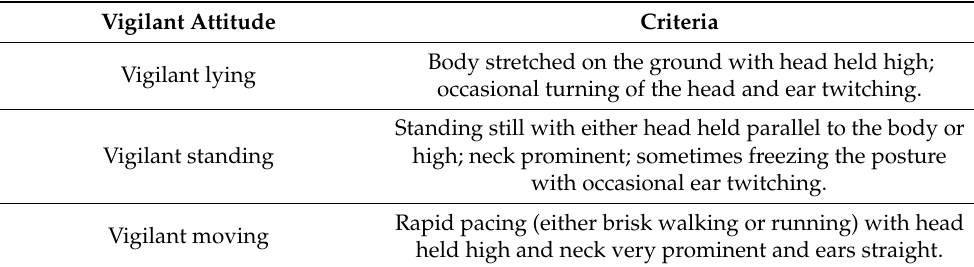
Table 2. Types of vigilant